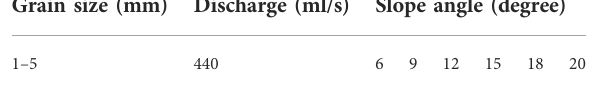
TABLE 3 The experimental